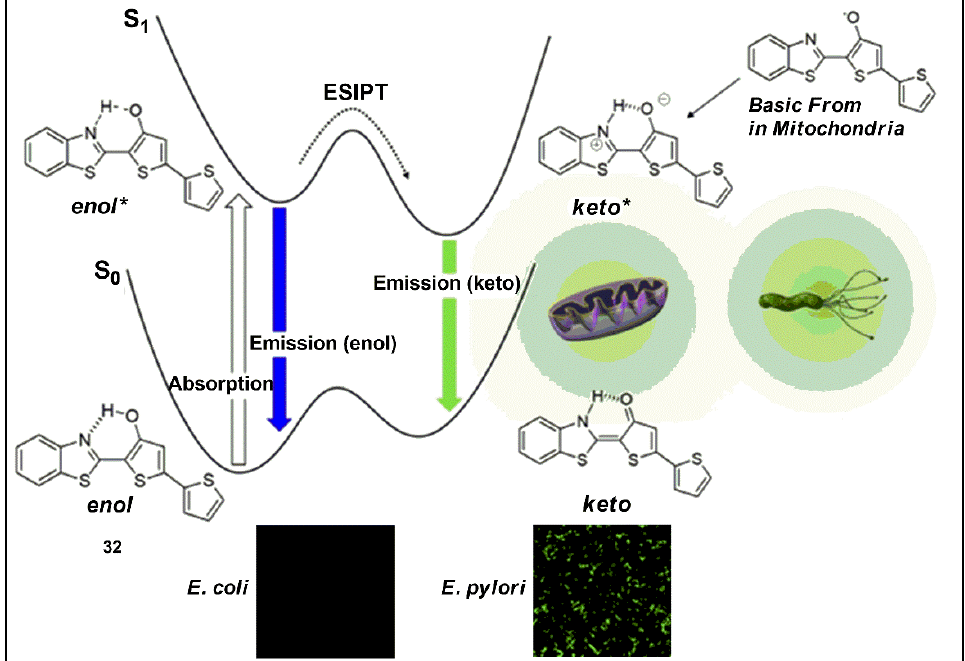
Figure 32. ESIPT probe 32 . Confocal images of E. coli and H. pylori cells were incubated with 10 μM T 2 (OH)B for 30 min. Adapted with permission from [107]. Copyright (2019) Elsevier.